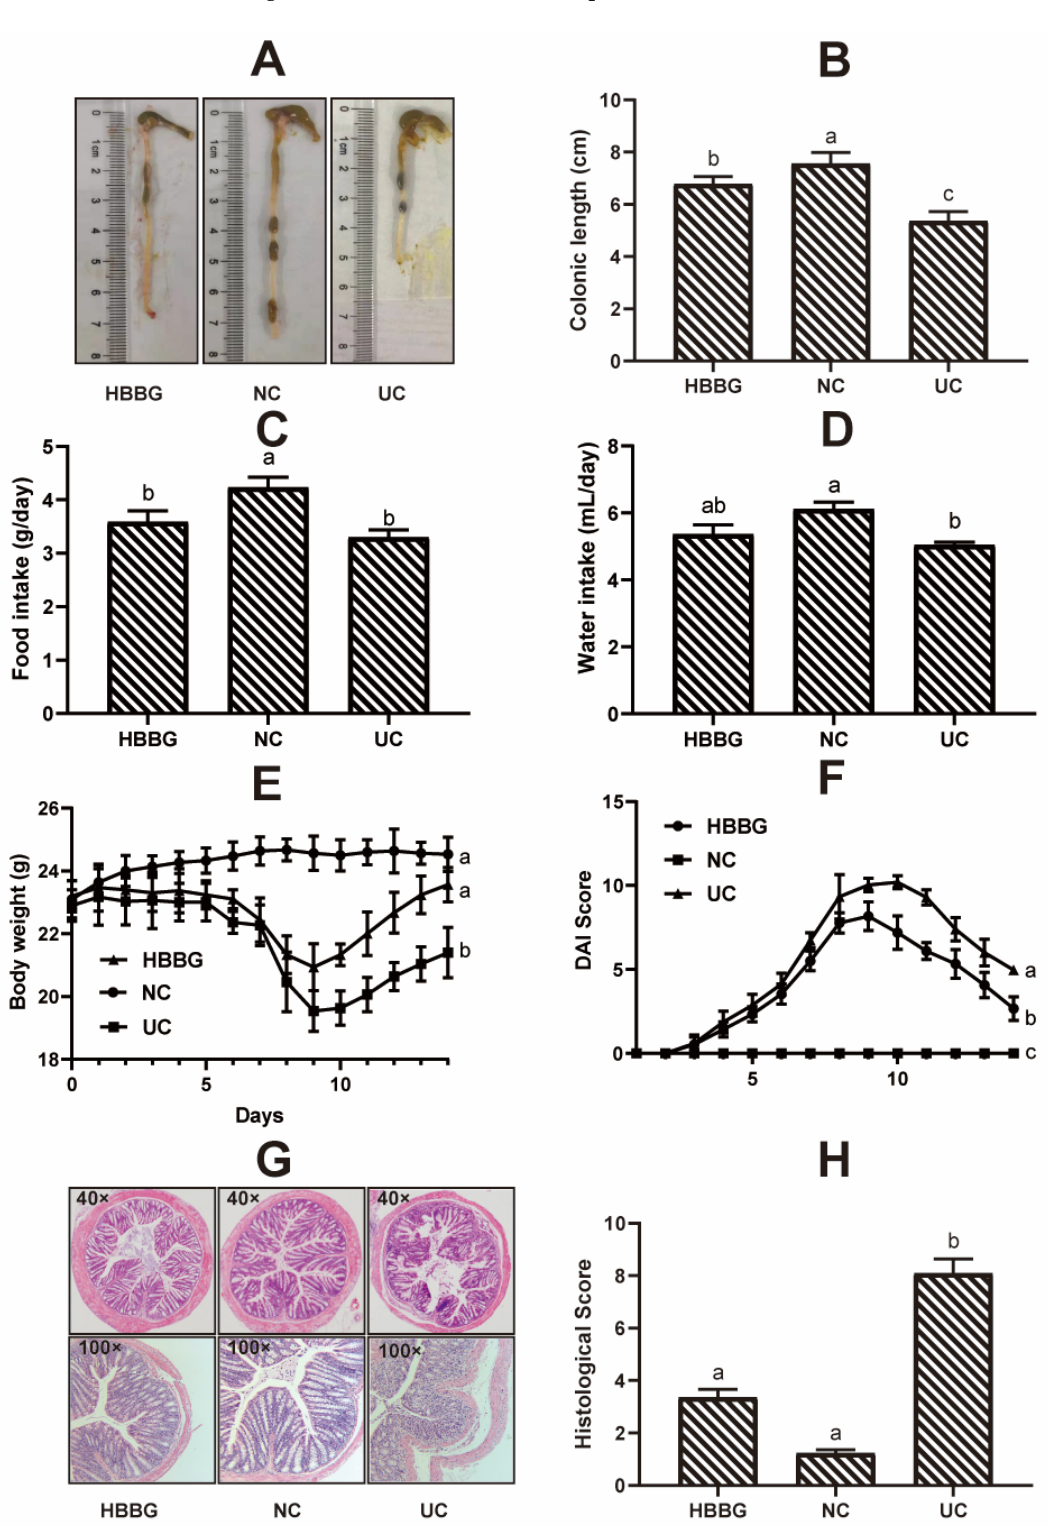
Figure 1. The effects of HBBG on histopathological indicators: ( A ) macroscopic pictures of colons; ( B ) colonic length; ( C ) food intake; ( D ) water intake; ( E ) body weight; ( F ) disease activity index (DAI); ( G ) histological examination; ( H ) colonic histological injury score. Different letters indicate statistically significant differences ( p < 0.05); on the contrary, the same letters indicate no statistically significant differences ( p > 0.05).